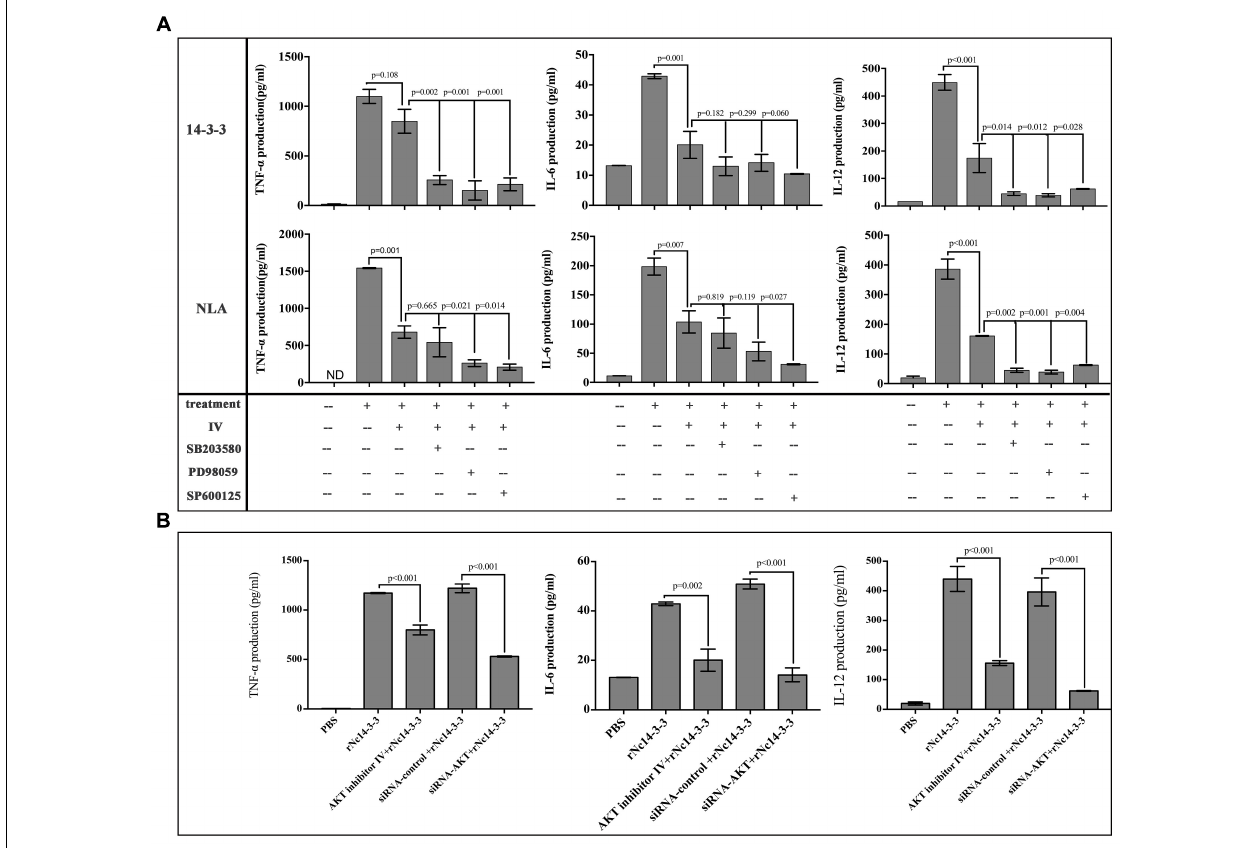
FIGURE 7 | The production of inflammatory cytokines was significantly reduced after blocking the AKT signaling pathway. (A) WT mouse PMs were pretreated with the MAP kinases inhibitors in addition or not AKT inhibitor IV before rNc14-3-3 or NLA treatment for 24 h, the production of IL-6, IL-12p40, and TNF- α in the supernatants was measured by ELISA. (B) WT mouse PMs were pretreated with AKT inhibitor IV or transfected with a small-interfering RNA targeting AKT for 24 h and then further stimulated with rNc14-3-3 for 24 h. The supernatants were removed and assayed for IL-6, IL-12p70, and TNF- α using ELISA. Data are expressed as the mean ± SD from three separate experiments. ∗ P < 0.05; ∗∗ P < 0.01; ∗∗∗ P < 0.001 for the inhibitor-treated group versus the Nc14-3-3 group or the inhibitor-treated group versus the NLA